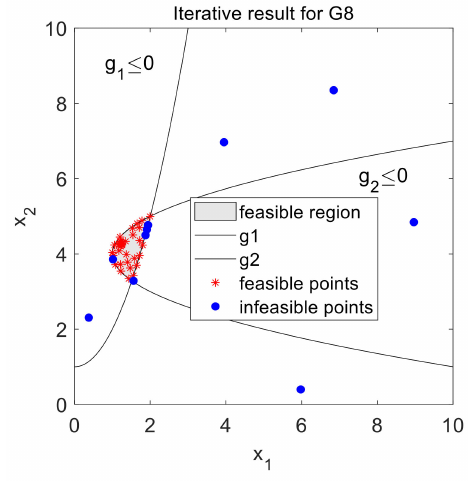
Figure 3. Iterative sampling results of